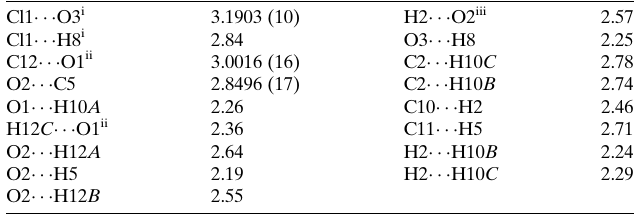
Table 2 Selected interatomic distances (A˚ ).